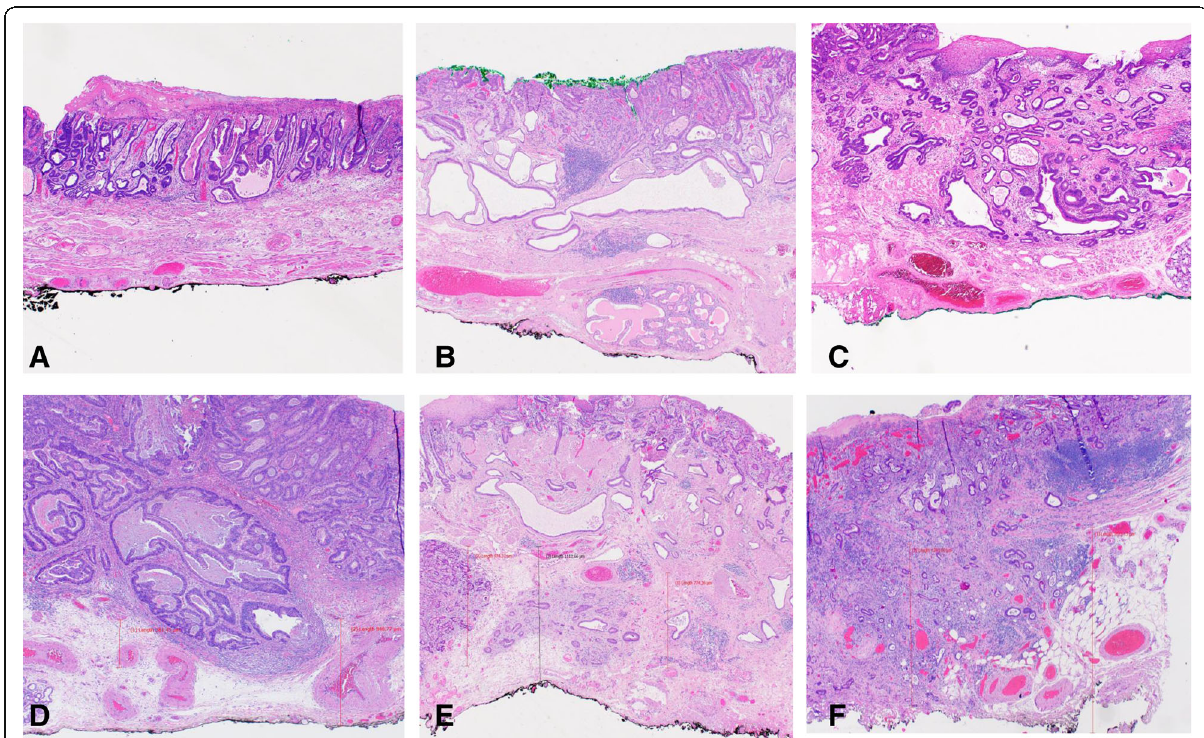
Fig. 3 A . Invasive intramucosal adenocarcinoma infiltrating into the superficial layer of muscularis mucosae, Vieth and Stolte DOI: m2. B . Invasive intramucosal adenocarcinoma infiltrating into layer between superficial and deep muscularis mucosae, Vieth and Stolte DOI: m3. C . Invasive intramucosal adenocarcinoma infiltrating into the deep layer of muscularis mucosae, Vieth and Stolte DOI: m4. D . Invasive intramucosal adenocarcinoma infiltrating into the superficial submucosa ≤ 500 μ m, Vieth and Stolte DOI: sm1. E . Invasive intramucosal adenocarcinoma infiltrating into submucosa to a depth between 500 to 1000 μ m, Vieth and Stolte DOI: sm2. F . Invasive intramucosal adenocarcinoma infiltrating into deep submucosa > 1000 μ m, Vieth and Stolte DOI: sm3. Hematoxylin and Eosin stain. ×